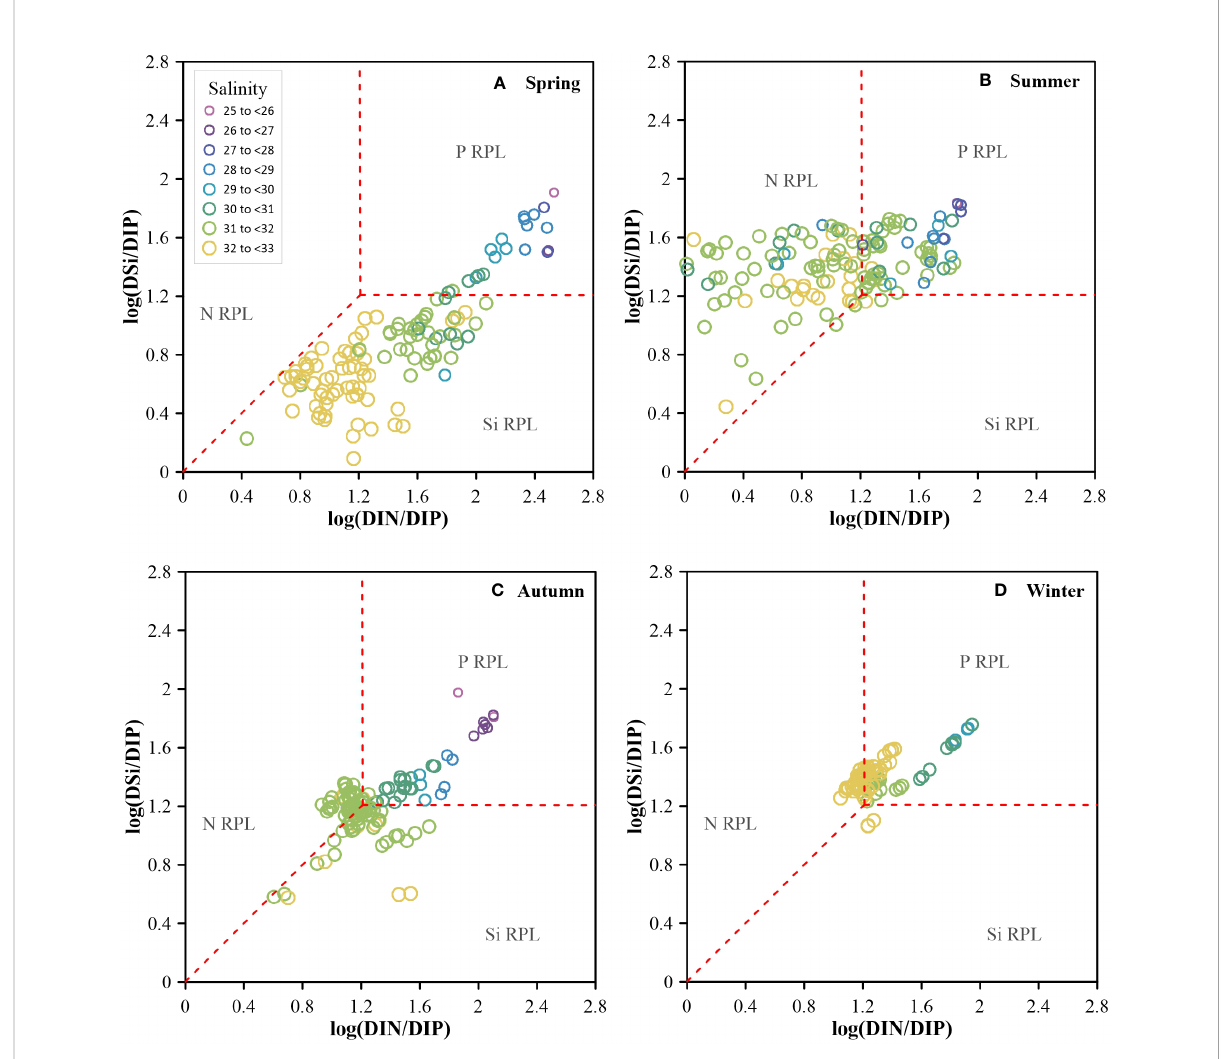
FIGURE 9 Log (DSi/DIP) vs. log (DIN/DIP) in spring (A) , summer (B) , autumn (C) and winter (D) . The red dashed line indicates DIN/DIP=16, DSi/DIP=16, and DSi/DIN=1. The rectangular area in the top right represents P Relative Potential Limitation (RPL) area; the lower trapezoidal area represents Si RPL area; and the left trapezoid represents N RPL